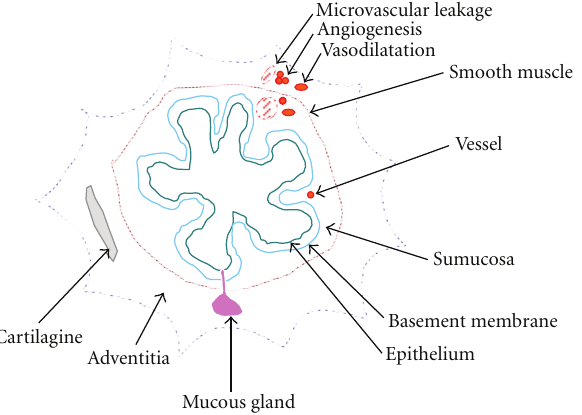
Figure 1: Schematic representation of bronchial airways wall. In asthma and COPD changes in bronchial microvasculature, such as angiogenesis, vasodilatation, and microvascular leakage, are present in response to inflammatory stimuli. Considering conventional therapy, only corticosteroids can positively act on all aspects of vascular